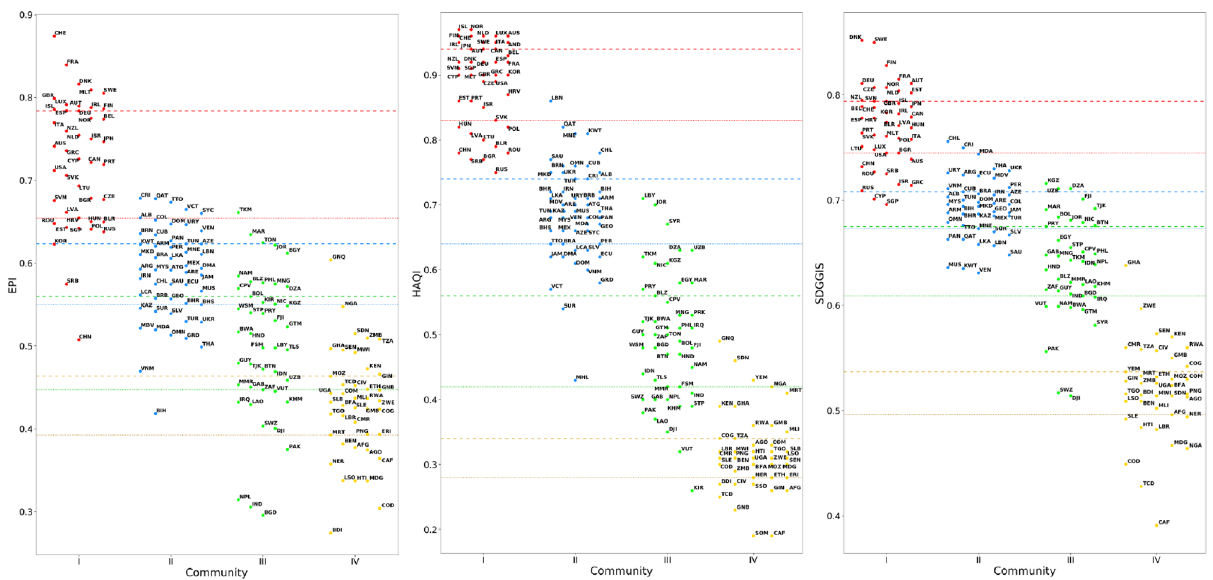
Figure 4. Distribution of EPI (left panel), HAQI (central panel) and SDGGIS (right panel) indexes of UN countries, separated in communities I (red), II (blue), III (green) and IV (yellow). Dashed and dotted lines of the same color as communities represent the 25th and 75th percentile, respectively, of the associated community distributions. While the horizontal grouping of points is related to the community membership of the countries they represent, the specific abscissa of a point is not meaningful. Higher-resolution versions of the above plots are reported in Supplementary Sec.